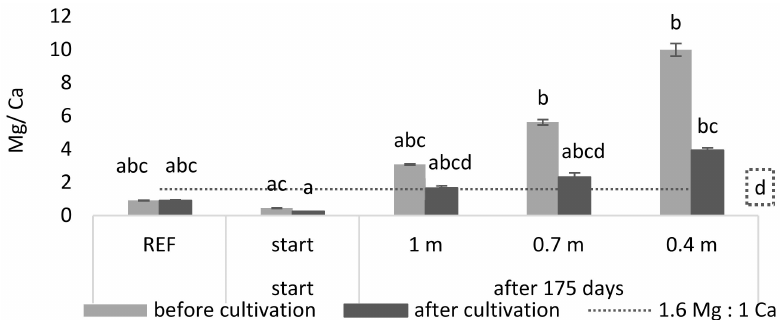
Figure 3. The Mg/Ca ratio in the medium of the simulated continuous system, before and after 175 growing days, with different buffering capacities. The dashed line indicates the minimum permitted Mg concentration in relation to the Ca concentration in the medium. Significant differences (n = 4 and p < 0.05) per graph are indicated by different letters. The letter in the dashed square belongs to the dashed line. Error bars indicate standard